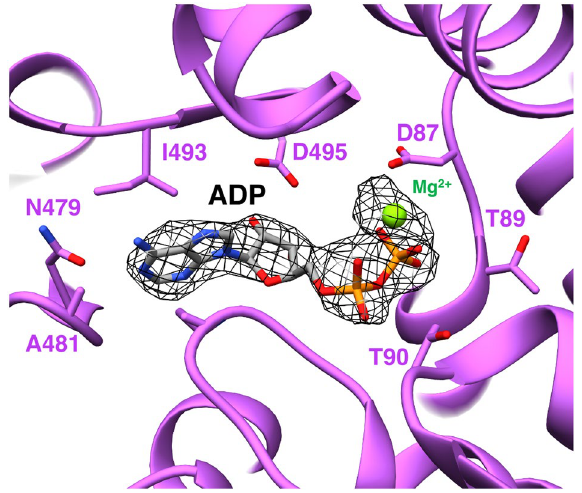
Figure 4. Density in the nucleotide-binding pocket (mesh) in a wide-conformation trans-ring with an atomic model of bonded ADP and